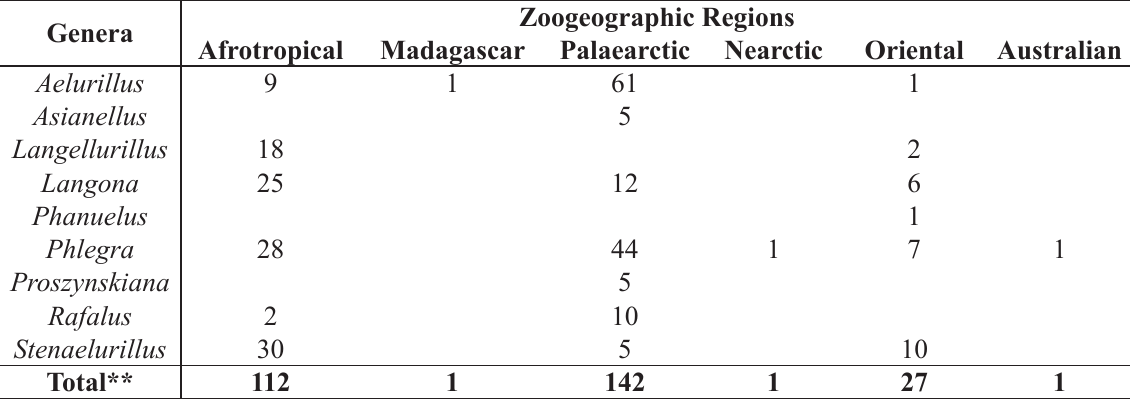
Table 3. Species numbers of nine genera of the Aelurillina in six zoogeographic regions. As there are no aelurilline species recorded from the Neotropical Region, it is excluded from the